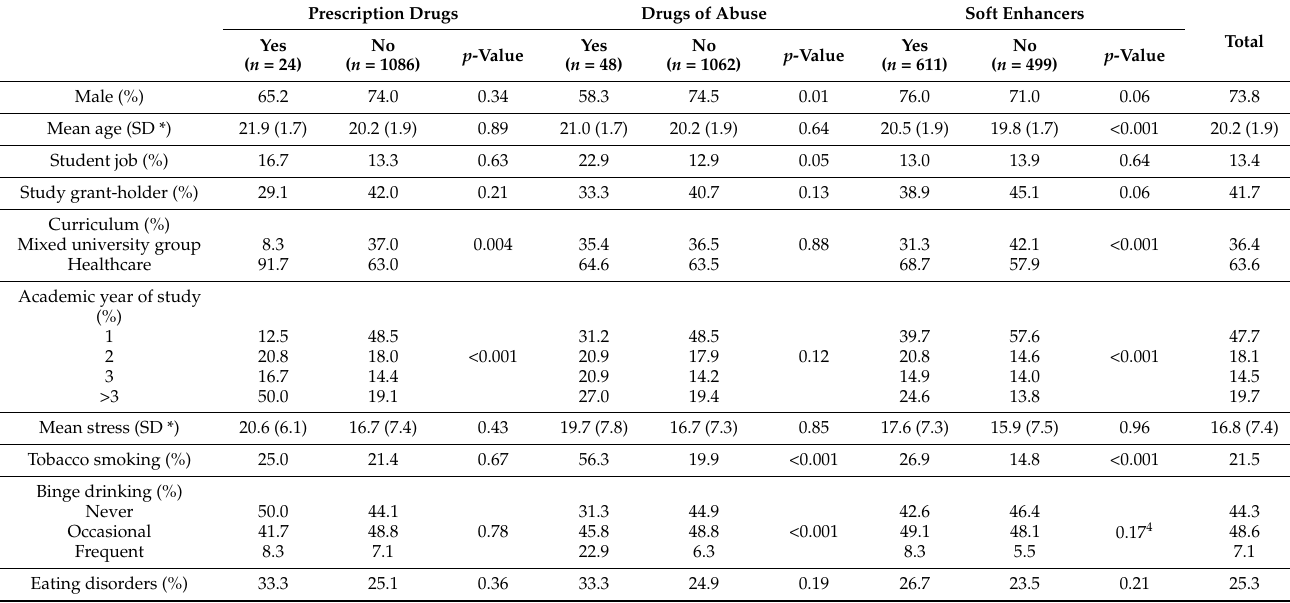
Table 3. Comparisons of the users of neuroenhancers of the three categories, according to sociodemographic characteristics, academic studies and risk behaviors among university students ( N =